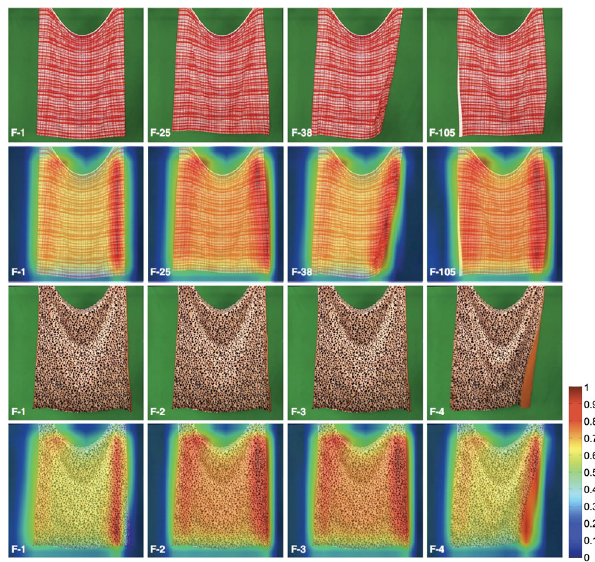
Fig. 4 Learned CNN conv5-layer activation visualization from Ref. [20]. Experiments show that the trained model is able to capture moving parts of the cloth even in an unseen video. Reproduced with permission from Ref. [20], c (cid:2) The Author(s) 2017.